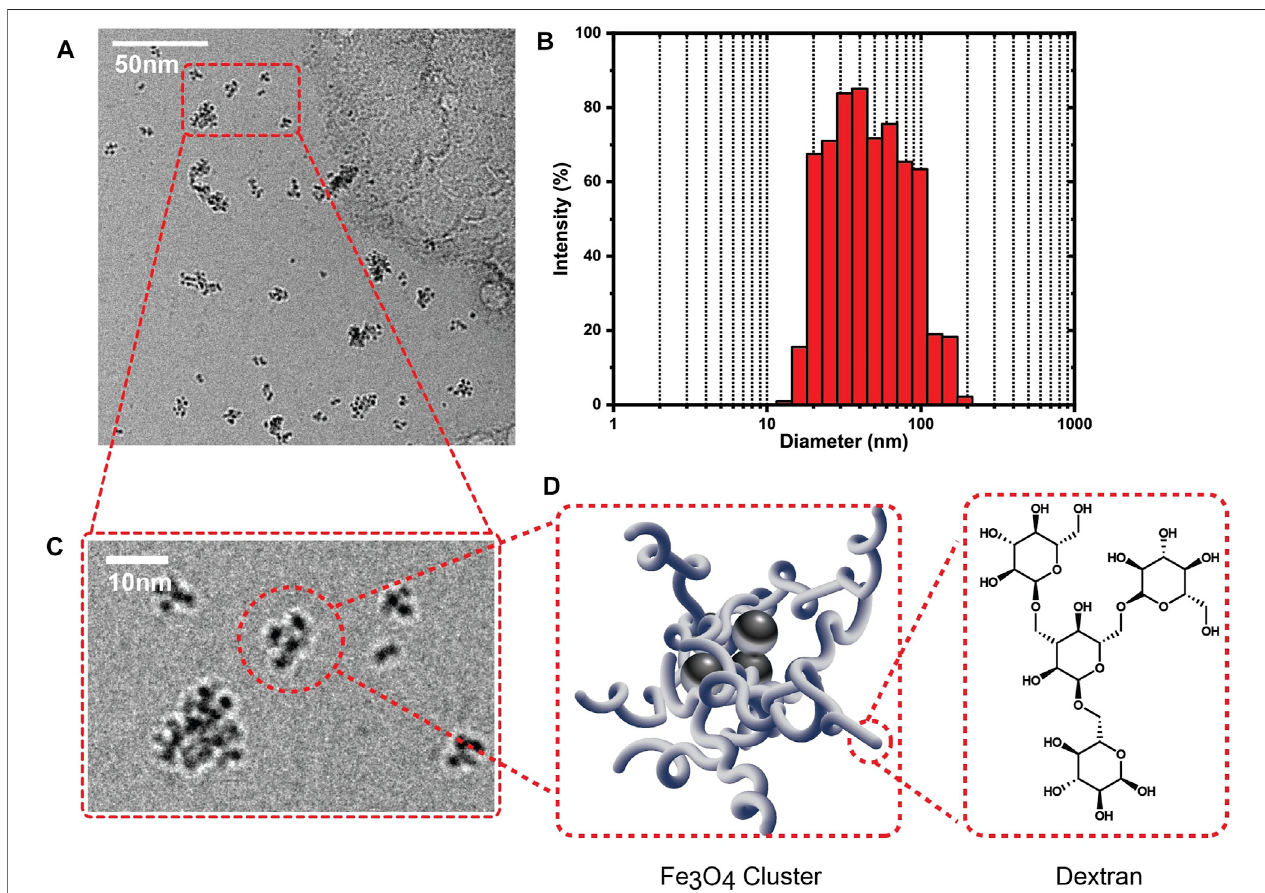
FIGURE1|(A) Cryo-TEMimageofDex-SPIONsinDIwater. (B) Graphshowing(intensity)averagesizedistributionofDex-SPIONs. (C) Magni fi edcryo-TEMimage of Dex-SPIONs. (D) Schematic depicting arrangement of dextran on periphery of a SPION bundle, featuring an inset of the atomistic structure of a dextran fragment.